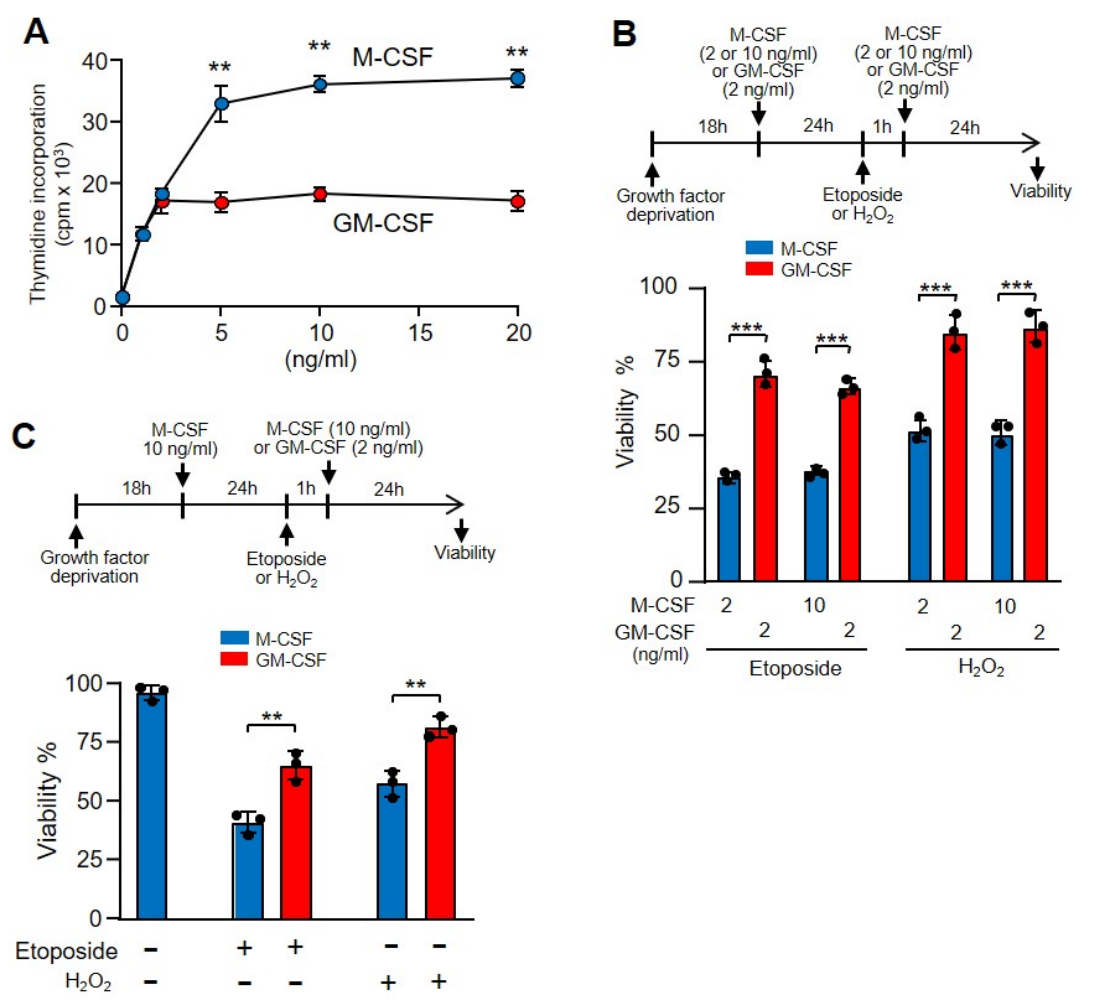
Figure 5. The different proliferation activity induced by GM-CSF or M-CSF was unrelated to the effect of etoposide. ( A ) Macrophages were incubated with M-CSF or GM-CSF at the indicated concentrations for 24 h and proliferation was measured as [ 3 H]-thymidine incorporation ( n = 3). ( B ) The experimental design is shown at the top. Macrophages were incubated in M-CSF or GM-CSF at the indicated concentrations for 24 h then treated for 1 h with etoposide or H 2 O 2 , washed and incubated again with M-CSF or GM-CSF for 24 h at the indicated concentrations, after which viability was quantified using Crystal Violet ( n = 3). ( C ) The experimental design is shown at the top. Macrophages were incubated in M-CSF (10 ng/mL) for 24 h, then treated for 1 h with etoposide or H 2 O 2 , washed and incubated again with M-CSF (10 ng/mL) or GM-CSF (2 ng/mL) for 24 h, after which viability was quantified using Crystal Violet ( n = 3). Each experiment was performed in triplicate, and the results are shown as the mean ± SD. ** p < 0.01 and *** p < 0.001 in relation to the corresponding treatments with M-CSF or GM-CSF, when all the independent experiments had been compared. Data were analyzed using Student’s t -test, with the exception of ( B , C ), which was performed using ANOVA test.